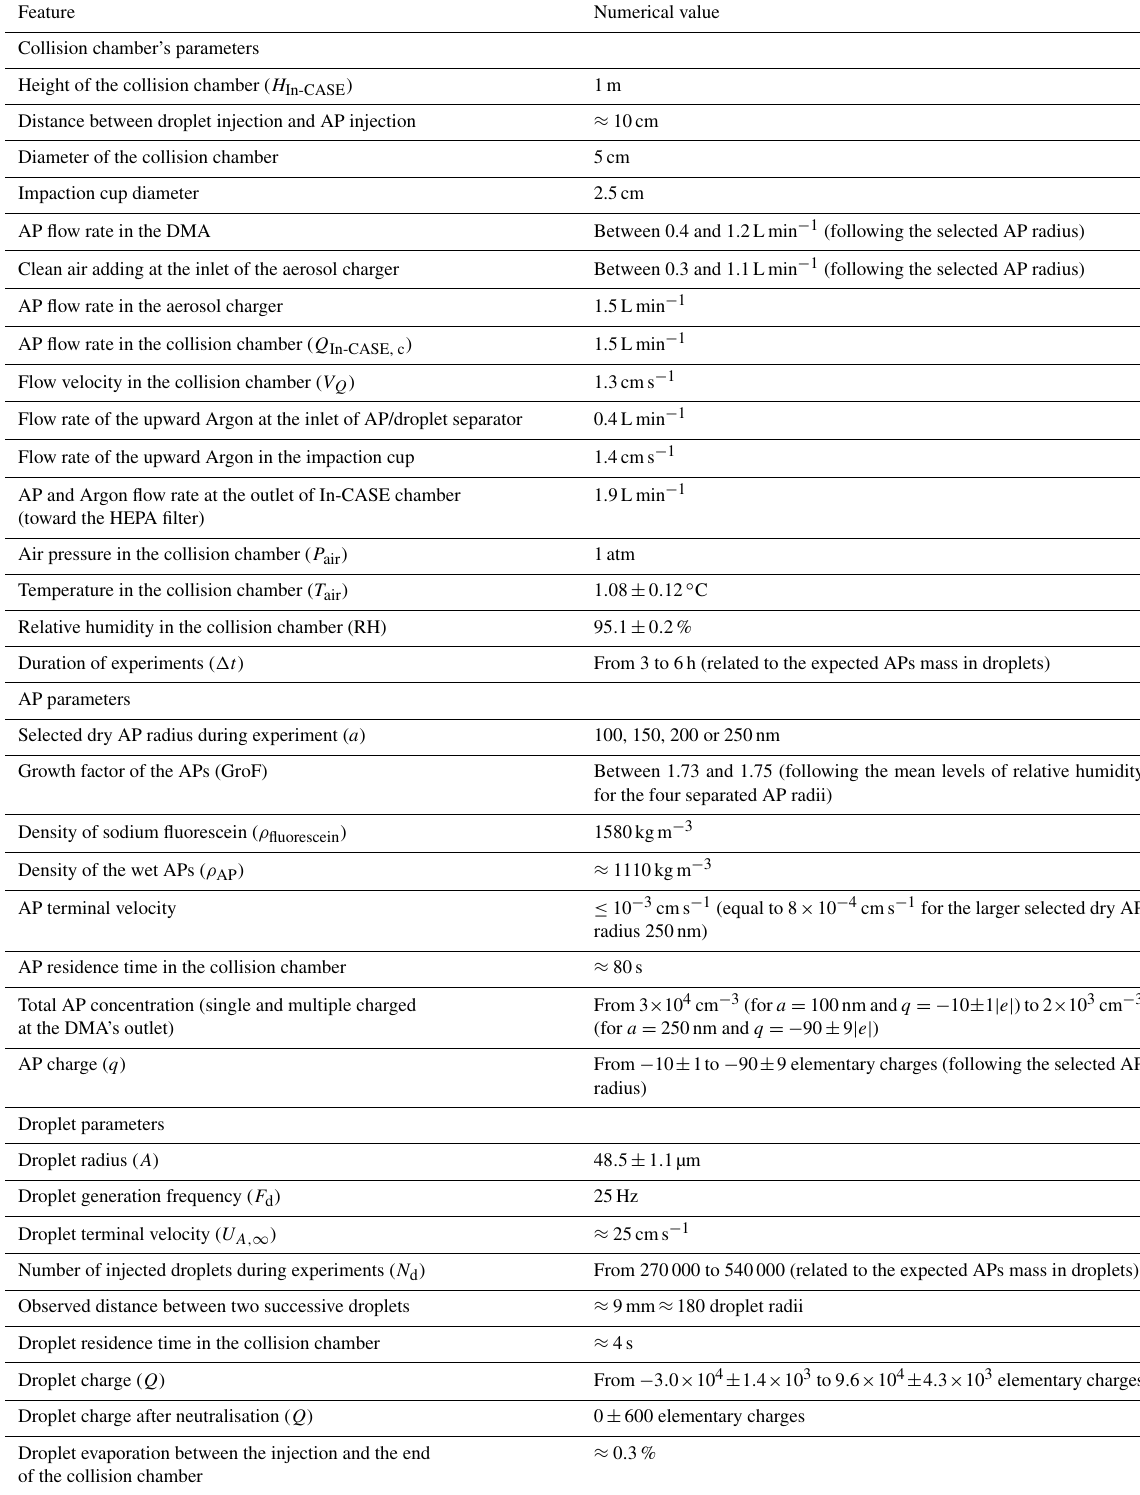
Table 5. Key features of the In-CASE